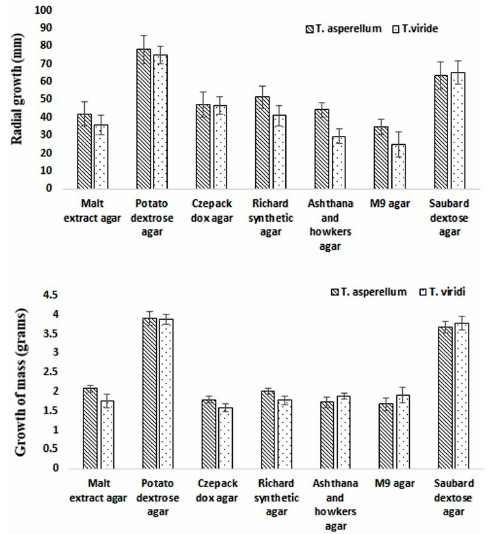
Fig. 3. Radial growth of T. asperllum and T. viride on different media